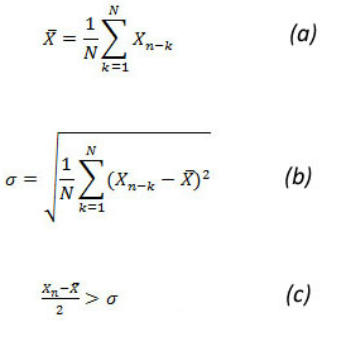
Figure 4. Historical cumulative sum (HCUSUM) equations. Sigma = standard deviation, X n = number of cases in current time interval, X-bar = mean number of cases. N = 5, as the baseline period is the preceding 5